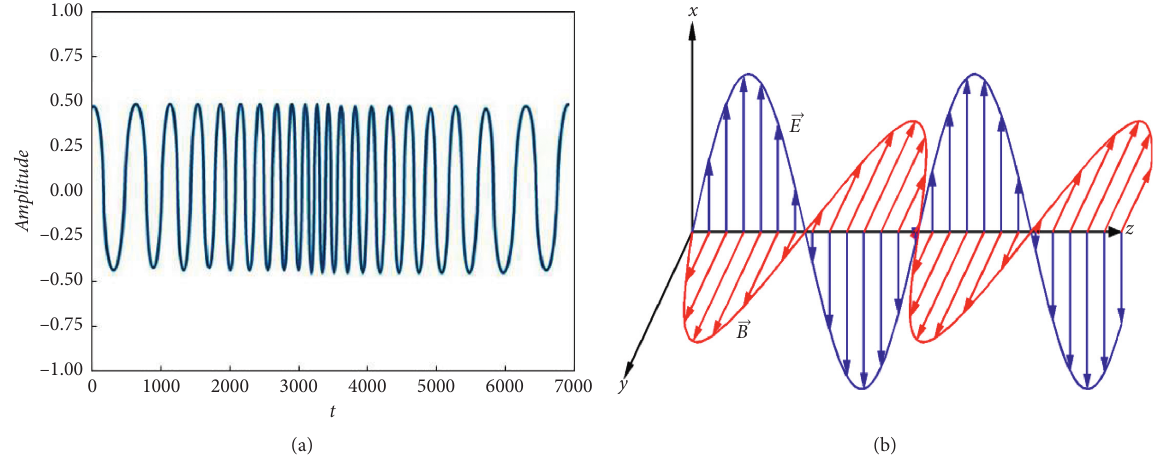
Figure 4: Classification of AE signal waveform. (a) Longitudinal wave (P-wave). (b) Transverse wave (S-wave).